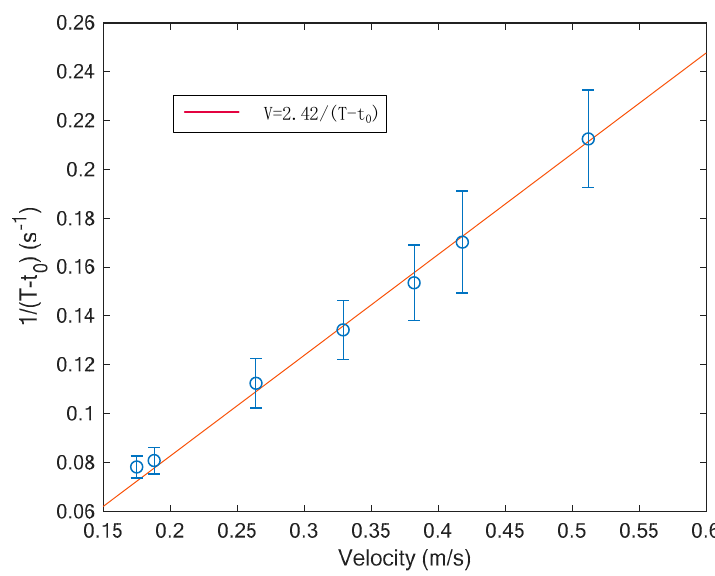
Figure 12. Experimental results of the velocity measurement.